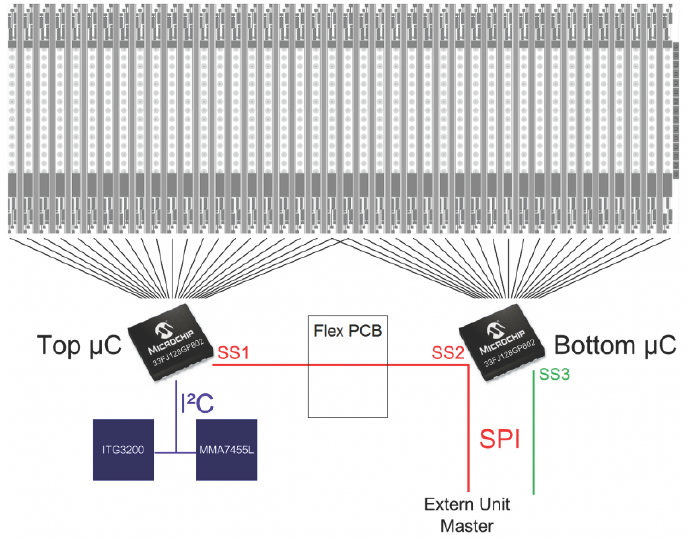
Figure 5. Communication interface between the two microcontrollers (the slaves) and an external processing unit (the master). Two slave-selected signals (SS1–SS2) are used to read the pixel values of the pre-defined regions of interest. The two inertial sensors are addressable by the external processing unit via the top